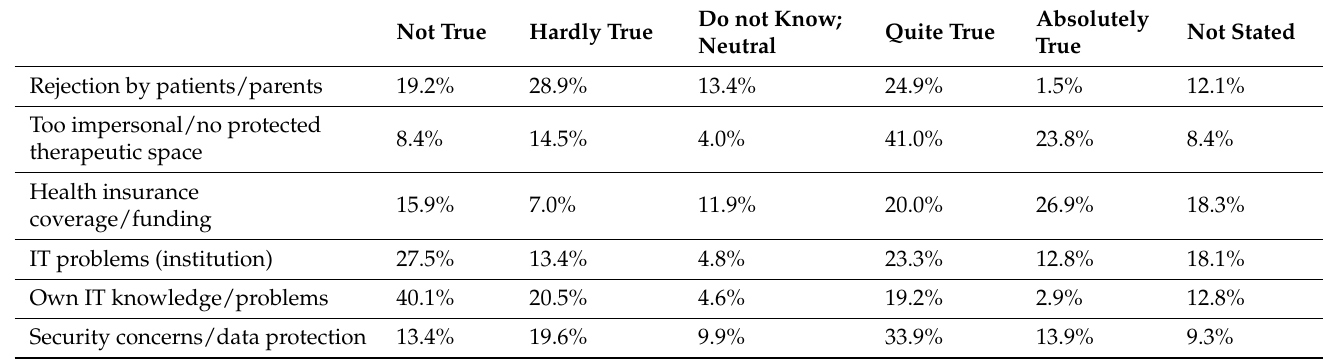
Table 7. Where do you see difficulties in the use of telemental health? (Percent of